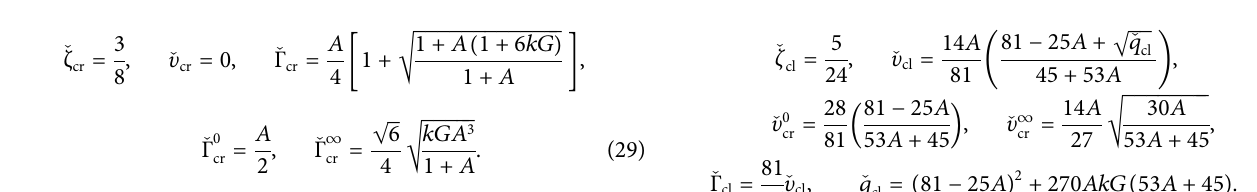
FIGURE 5 | Shear as a function of spike curvature for various acceleration strengths when A (cid:1) 3/4, various Atwood numbers when kG (cid:1) 1.